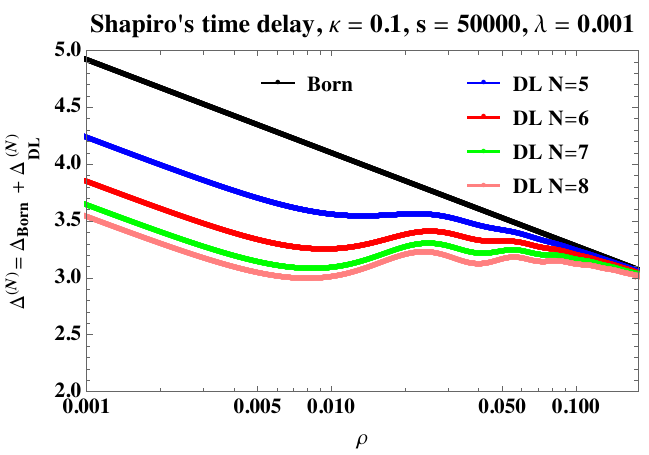
Figure 15 . Shapiro’s time delay for graviton-graviton scattering at Born level and for di(cid:11)erent supergravity theories with DL accuracy. The center of mass energy is chosen to be large, s =